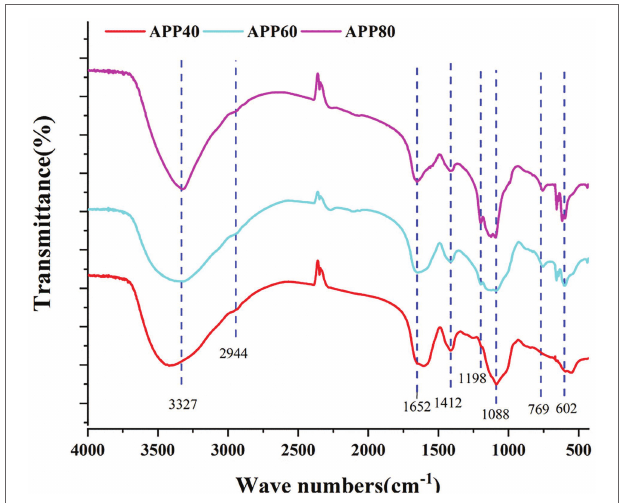
FIGURE 6 | The Fourier transform infrared (FT-IR) analysis of precipitated at the ethanol concentration of 40% (APP40), precipitated at the ethanol concentration of 60% (APP60), and precipitated at the ethanol concentration of 80%